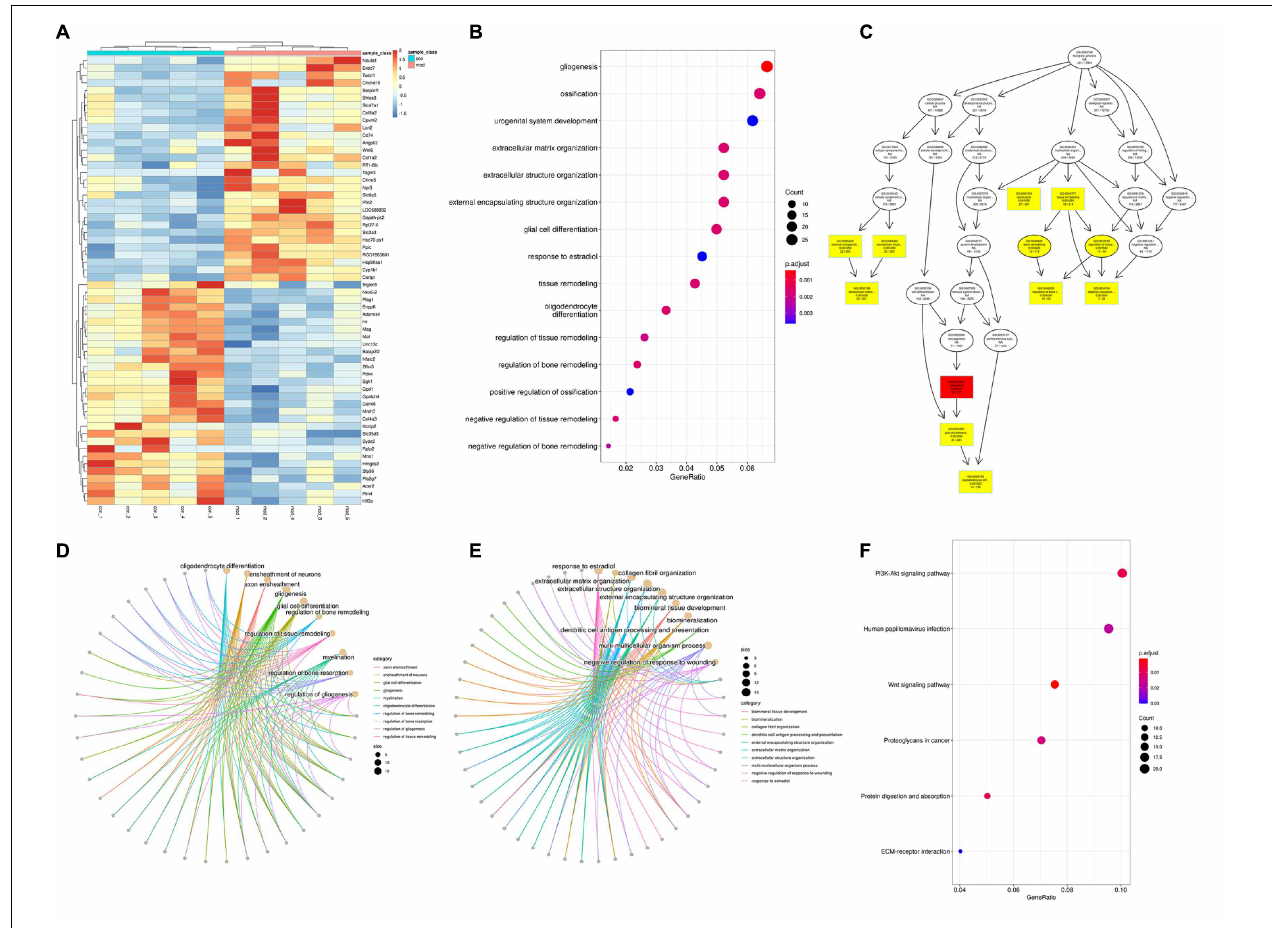
FIGURE 8 | Differentially expressed analysis in autism group compared with the control group ( n = 5 in each group). (A) Hierarchical clustering heatmap of the top 50 DEGs in the VPA-exposed group compared with the control group. (B) GO biology process enrichment analysis of the DEGs. The x axis indicates the enrichment ratio, and the y axis indicates the GO terms. The size of the circle represents the gene number, and the color of the circle indicates the value (adjusted p value). (C) Directed acyclic graph of GO biology process in DEGs, the depth of the color represents the degree of enrichment. (D,E) GO biology process enrichment analysis of down-regulated and up-regulated genes. The size of the circle represents the gene number, and the color of the line indicates clustering of biological processes (F) KEGG enrichment analysis of DEGs. The x axis indicates the enrichment ratio, and the y axis indicates the KEGG terms. The size of the circle represents the gene number, and the color of the circle indicates the value (adjusted p